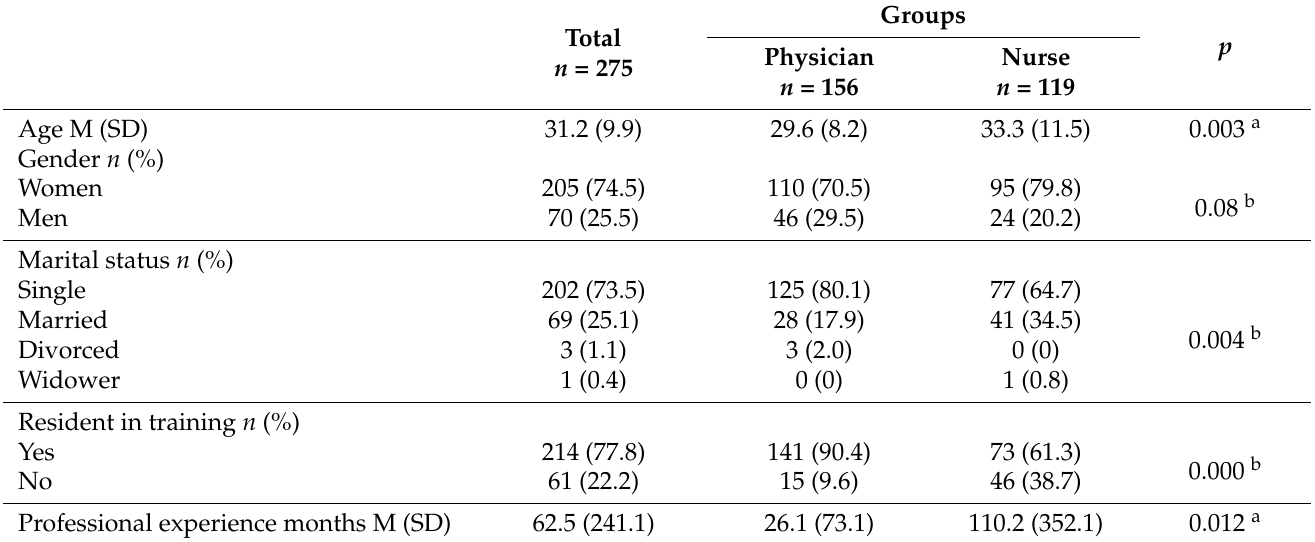
Table 4. Participants’